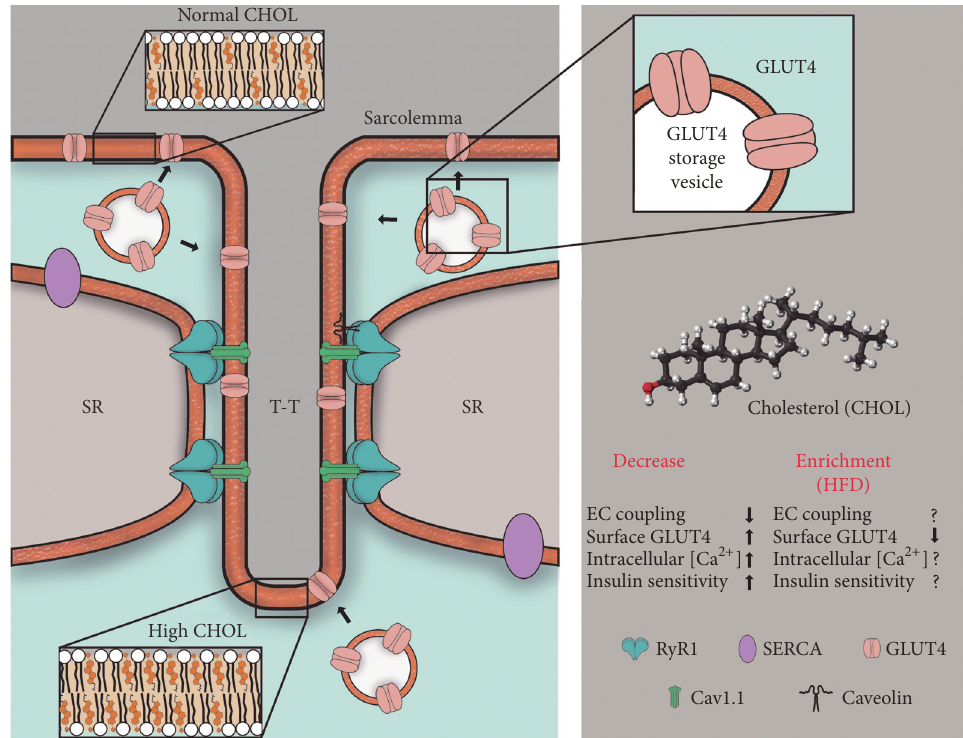
Figure 1: Schematic figure showing the T-tubule (T-T) system and its high cholesterol content compared with the surface membrane (sarcolemma, see inserts). Note the main proteins of the EC coupling complex and the sites of GLUT4 translocation. In response to insulin, the GLUT4 transporters translocate mainly to the T-tubule system, where EC coupling takes place, and also to the surface membrane region. Modifications of cholesterol content affect both EC coupling and GLUT4 mediated glucose transport in skeletal muscle. ↑ : increment; ↓ : decrease; ?: unknown